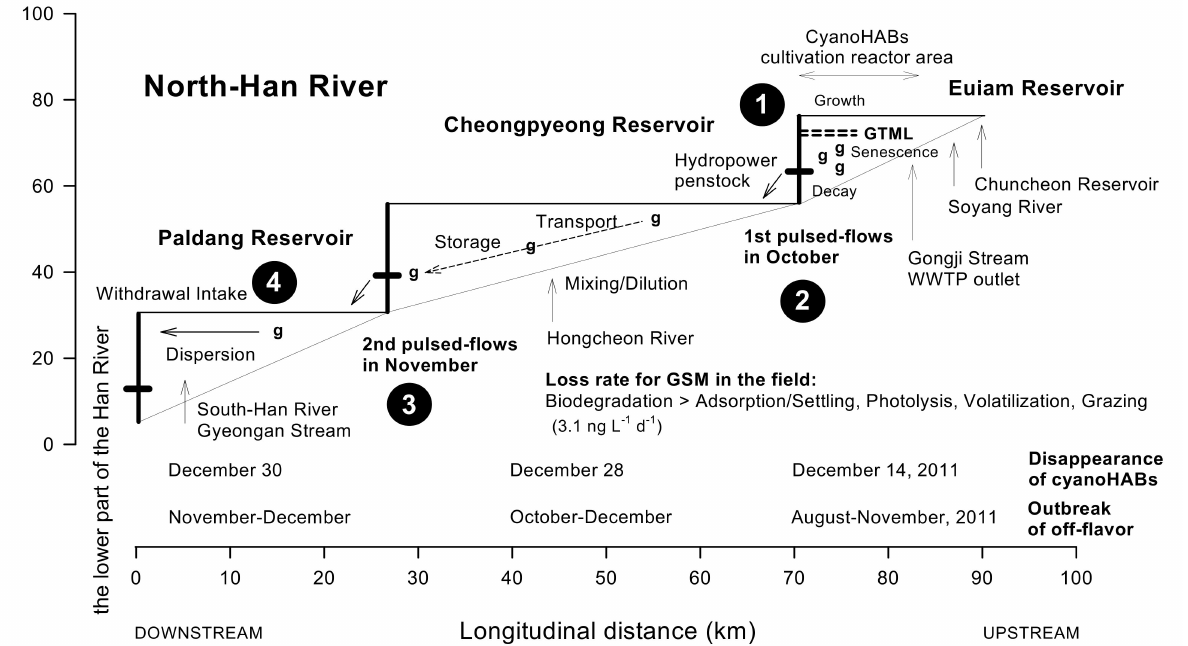
rate for GSM in the field: Biodegradation > Adsorption/Settling, Photolysis, Volatilization, Grazing